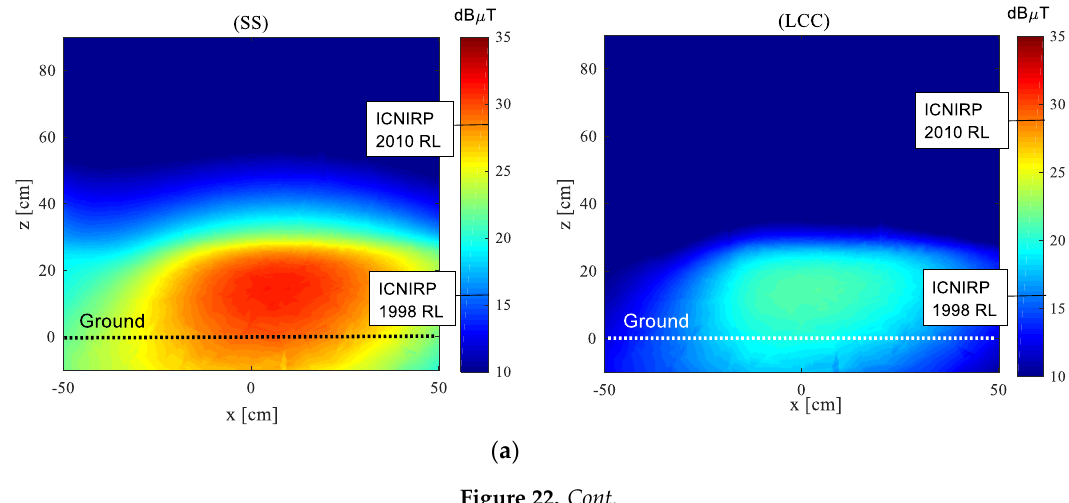
Figure 22. Cont. Figure 22.